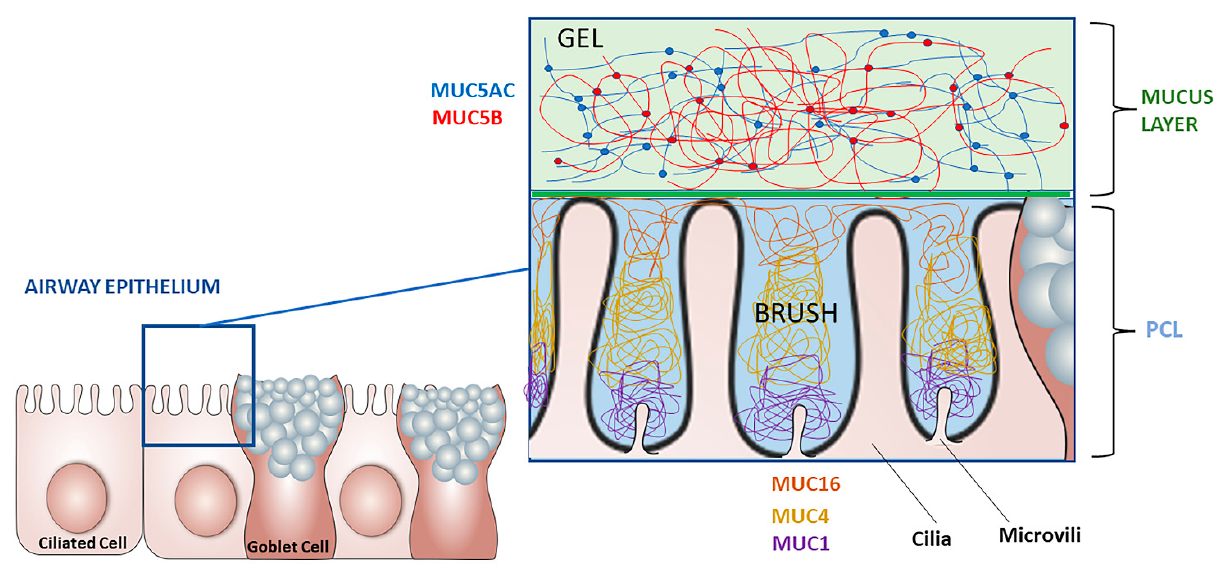
Figure 1. Two-gels model of mucus transport, inspired from Richard C. Boucher—The New England Journal of Medicine. (PCL: periciliary layer).